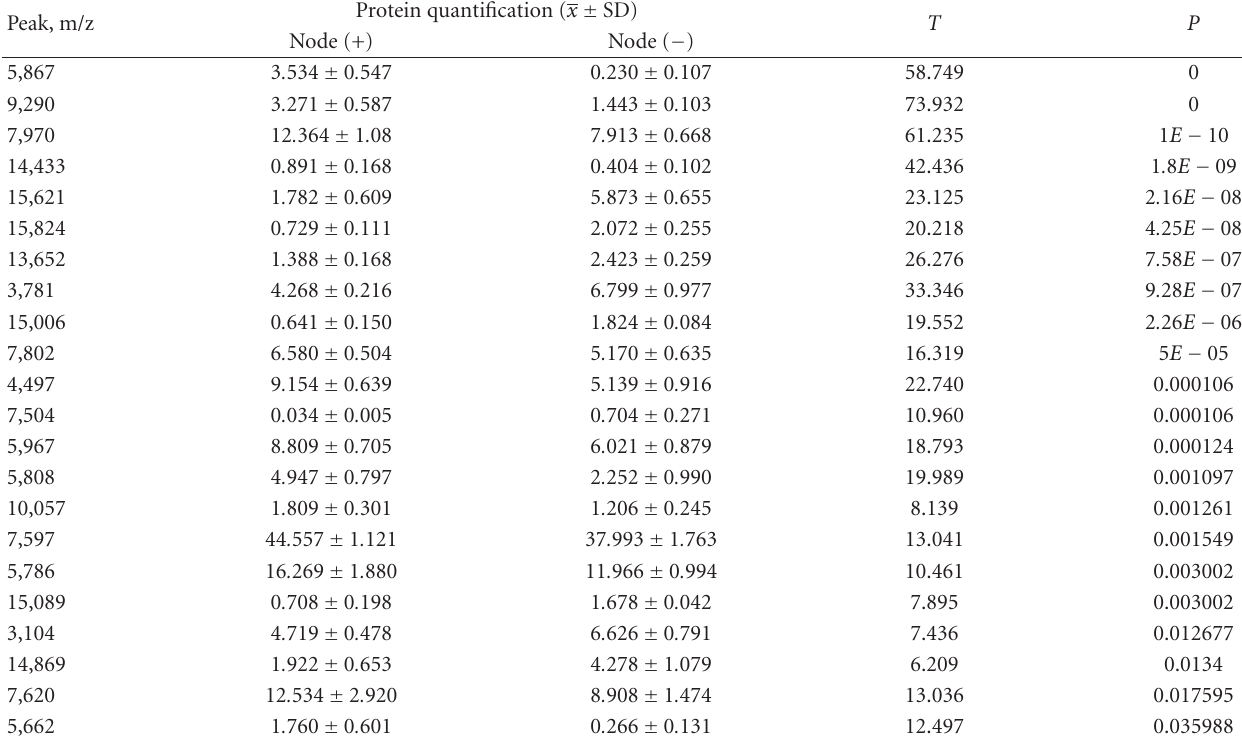
Peaks were named by their mass to charge ratio